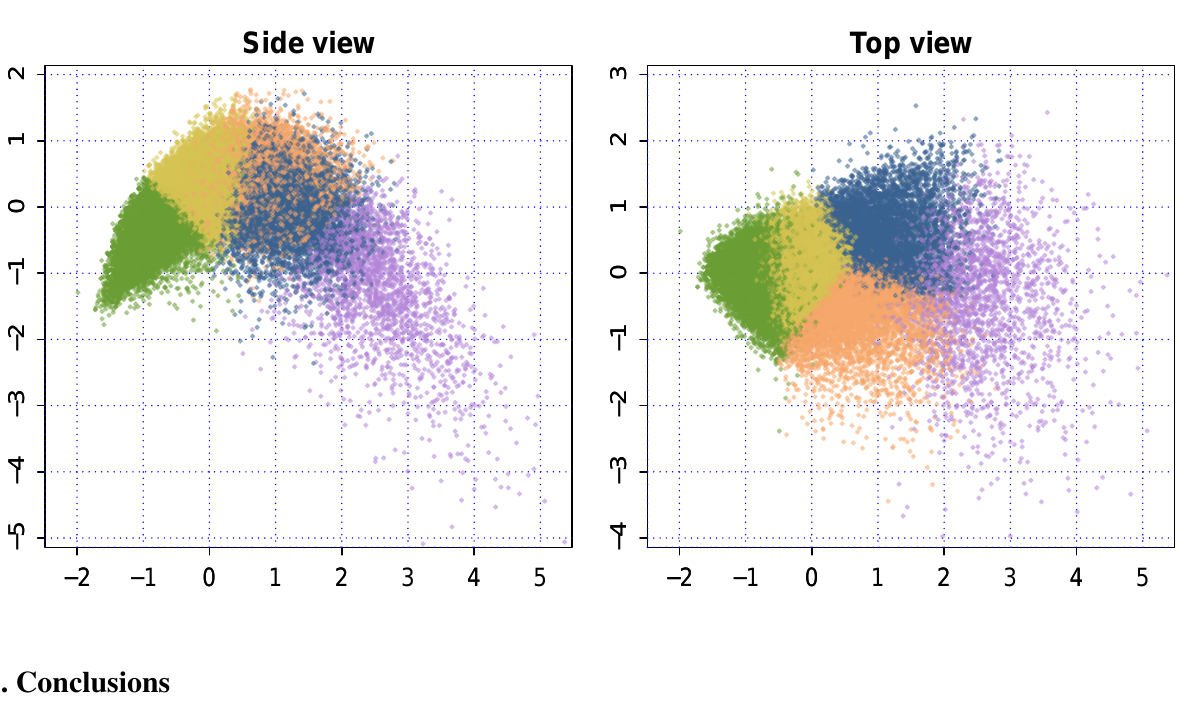
Figure 6. Side and top view of persons colored by allocated